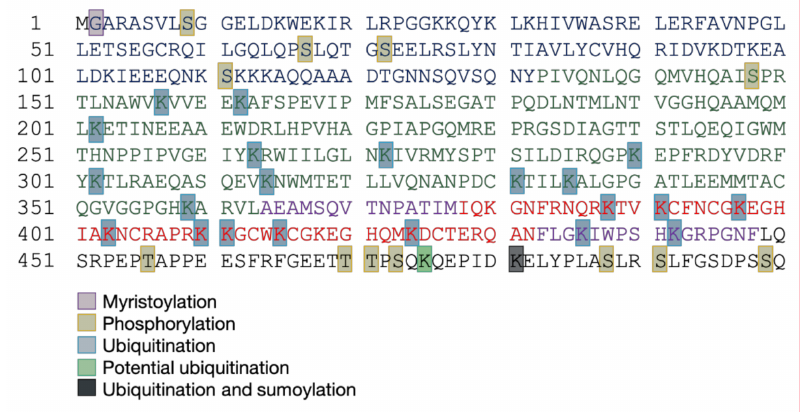
Figure 10. Summary of post-translational modifications of HIV-1 Pr55 Gag residues. The domains of Pr55 Gag are represented by different colors (see Figure 4). Experimentally identified modified residues are highlighted: myristoylation (pink), phosphorylation (yellow), ubiquitination (light blue), potential ubiquitinations (light green), and sumoylation